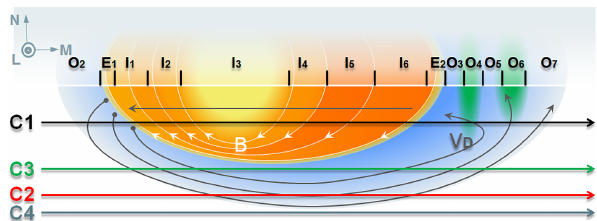
Figure 11. A schematic interpretation of the structure of the FTE and surrounding regions on the MN plane: the relative spacecraft trajectories during the FTE observation are demonstrated in Clus- ter standard colour code. The four spacecraft do not pass the FTE simultaneously. In fact Cluster 1 was the last spacecraft which ob- served the FTE, and made the deepest entry. Cluster 3 and 2 only observed the boundary layer, and Cluster 4 only observed the draped magnetospheric field lines. The white arrows represent the projec- tion of the magnetic field onto the MN plane. These magnetic fields also have strong component along the L direction, and separate the multiple plasma layers identified by PEACE. These layers consist of the edges, outer and inner layers of FTE and are marked in black region codes. The colours of these layers illustrate the variation in differential energy flux of the electrons, which are based on LEEA high-time-resolution observations. The grey stream lines (arrowed) are the inferred E × B drift velocity. These arrows show that the core is moving towards the dusk, while the boundary layer plasmas have a circular motion around the core. In the wake of the FTE, the motion of boundary layer follows the